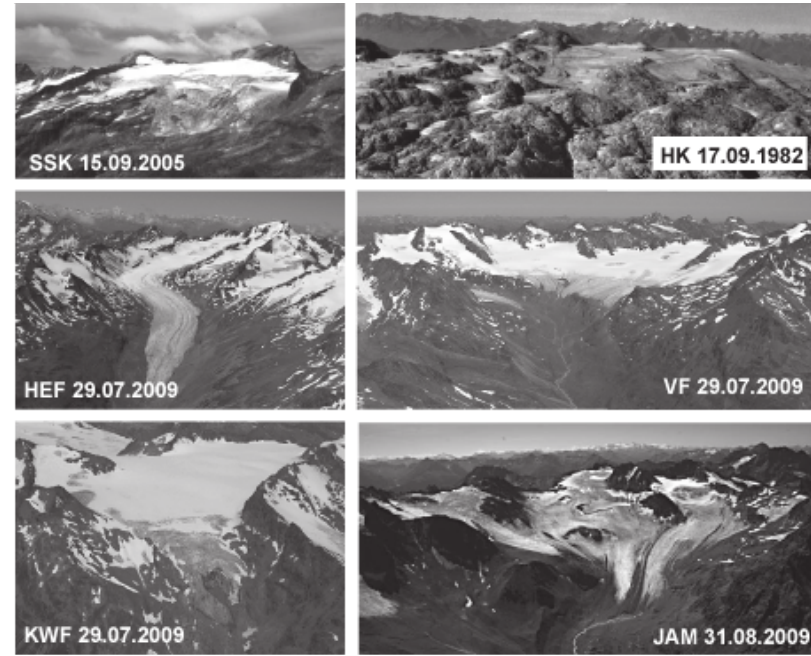
Fig. 4. Oblique photographs of the plateau glaciers SSK and HK, and the valley glaciers HEF, VF, KWF and